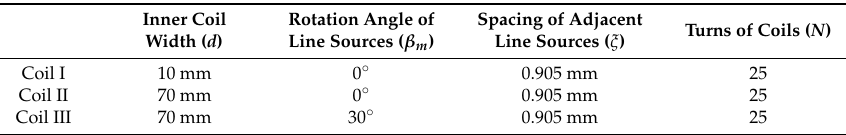
Table 2. The geometrical parameters of the coils